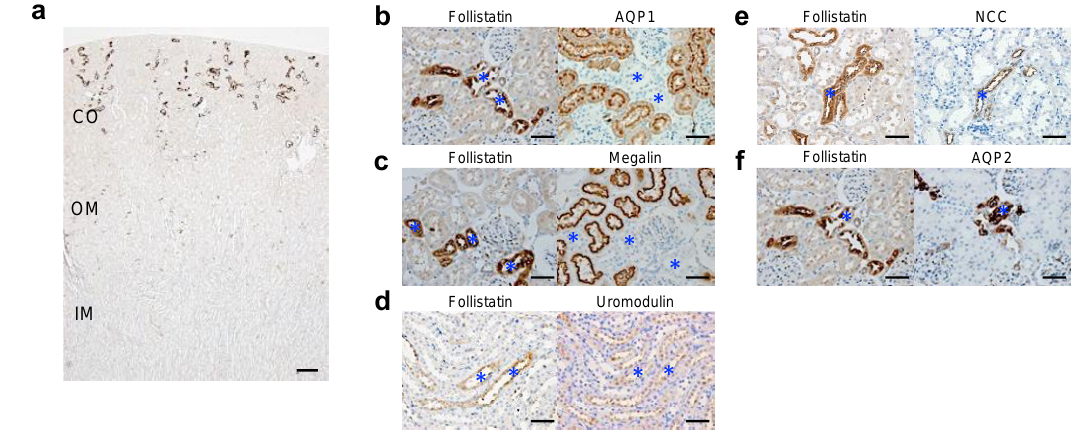
Figure 1. Localization of the follistatin protein in normal rat kidneys. ( a ) Localization of follistatin (brown) in normal rat kidneys was examined by immunostaining. Cortex, CO; outer medulla, OM; inner medulla, IM. Bar = 0.2 mm. ( b – f ) Identification of follistatin-positive tubules in rat normal kidneys using serial sections. Aquaporin 1, AQP1; Na-Cl co-transporter, NCC; aquaporin 2, AQP2. Asterisks indicate identical tubules. Bar = 50 μm.